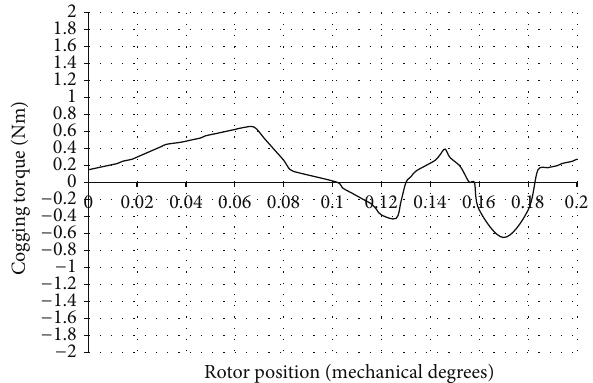
Figure 10: Cogging torque waveform after shifting of slot openings.